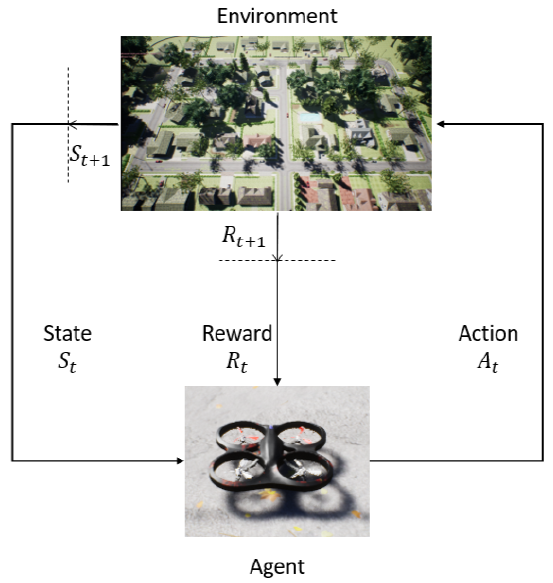
Figure 1. The agent-environment interaction in reinforcement